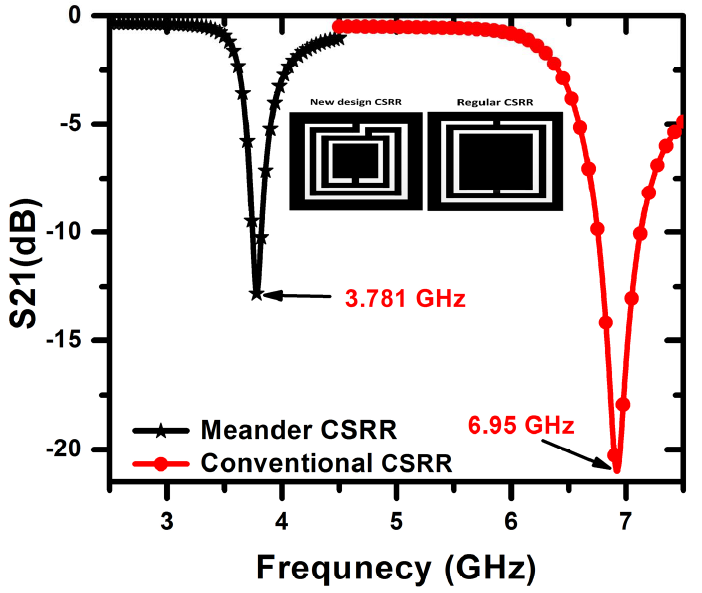
Figure 16. Minimum transmission coefficient of the two sensor obtained from HFSS at the resonance frequency of the 3 -mm CSRR.